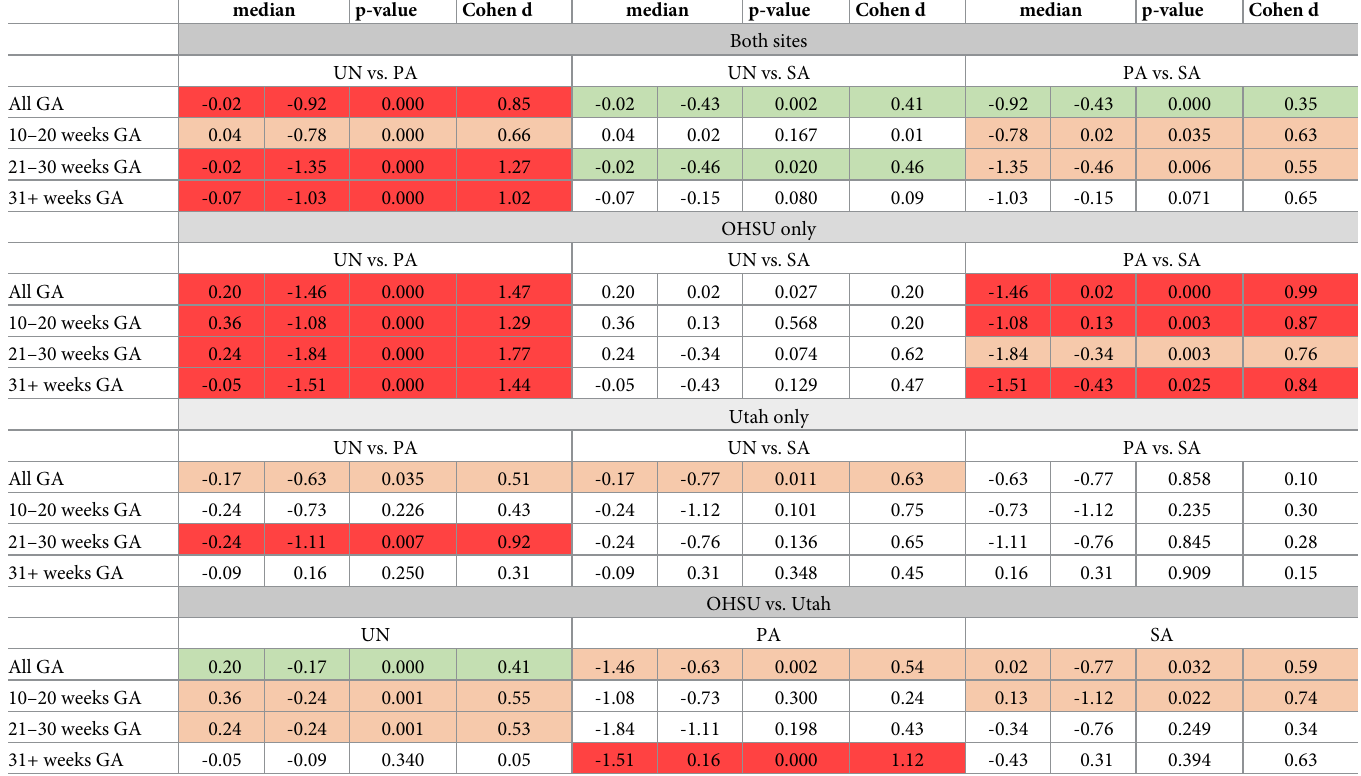
Table 5. Placental T2 � z-scores, with p-values and effect sizes (Cohen’s d), for study subjects stratified by category, site, and gestational age (GA) range. Effect size is considered small (green cells) when p < = 0.05 and 0.2 < = d < 0.5, medium (orange cells) when p < = 0.05 and 0.5 < = d < 0.8, and large (red cells) when p < = 0.05 and d > =